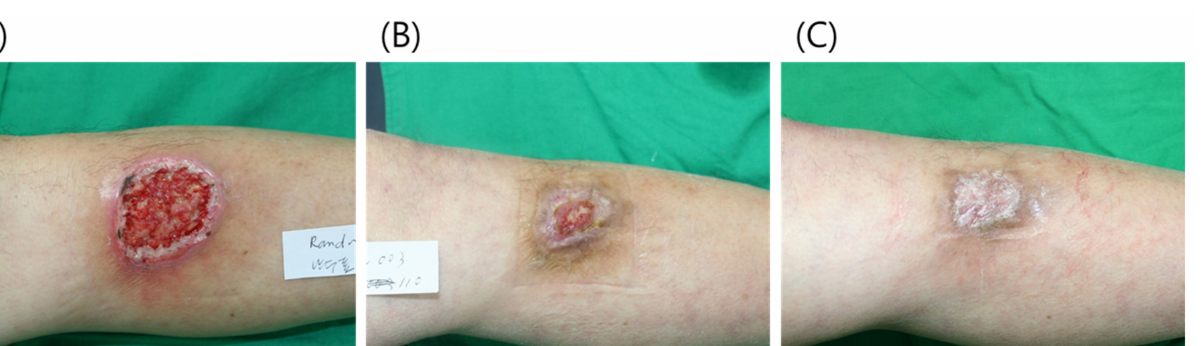
Figure 7. ( A ) A 52-year-old male patient presented with a 5 × 4 cm skin defect on his lower left leg. ( B ) At 8 weeks after initial treatment, the wound size had reduced to 1.5 × 2 cm. ( C ) At 12 weeks, the wound was completely healed without contracture